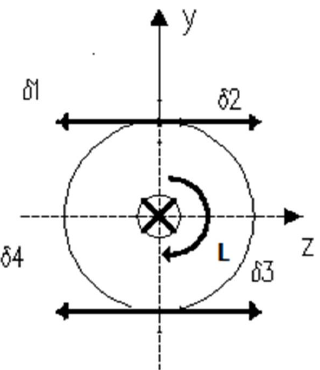
Figure 3. Schematic diagram of the four reactive elements—RCS.